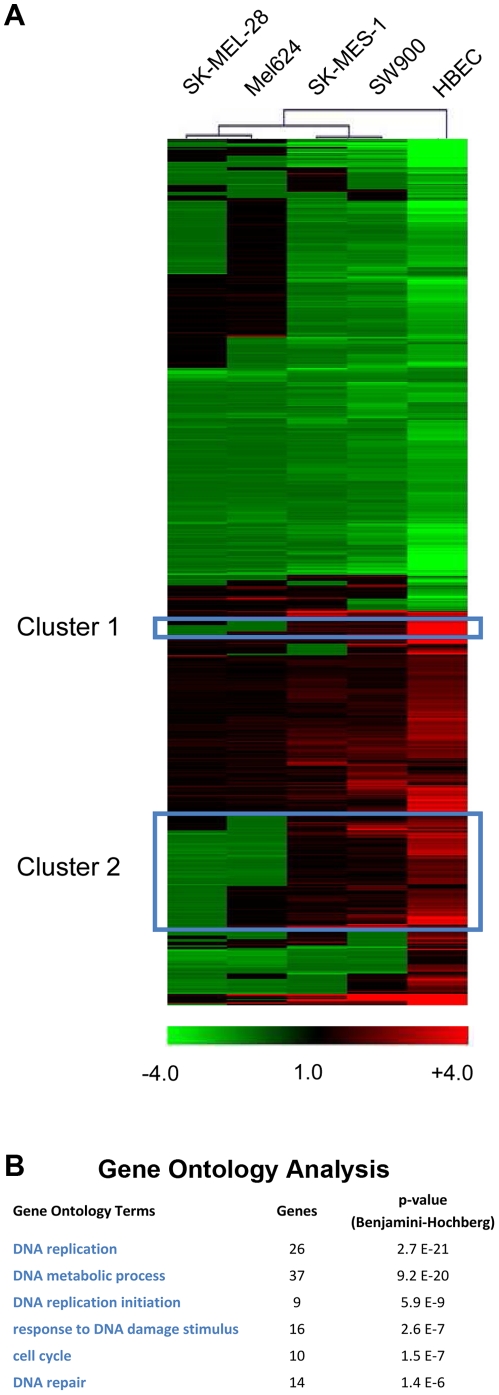
Hierarchical clustering of HAdV-5-induced gene expression in HBEC and tumor cells.(A) Hierarchical clustering of genes using Multi-Experiment Viewer (MeV 4.5.1) based on the approx. 1000 most significantly regulated genes (see

Materials and Methods

 for data filtration criteria). Clusters of genes showing opposing regulation by HAdV-5 infection in HBEC versus melanoma cells are framed. Magnifications of these clusters are presented in Fig. S4. (B) Lists of genes within cluster 2 were subjected to gene ontology analysis using the Database for Annotation, Visualization and Integrated Discovery (DAVID;
david.abcc.ncifcrf.gov). P-values of GO terms were corrected for multiple testing using the Benjamini-Hochberg algorithm.